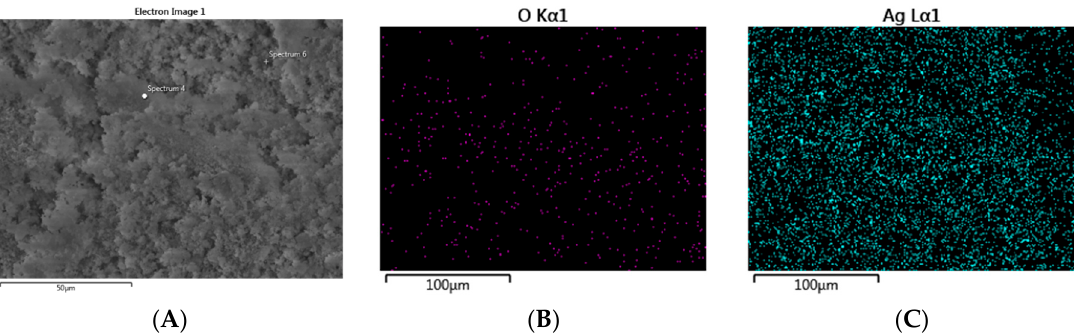
Figure 1. SEM image accompanied by EDX qualitative analysis. The dot marks the location of EDX ( A ). EDX chemical maps ( B – C ).